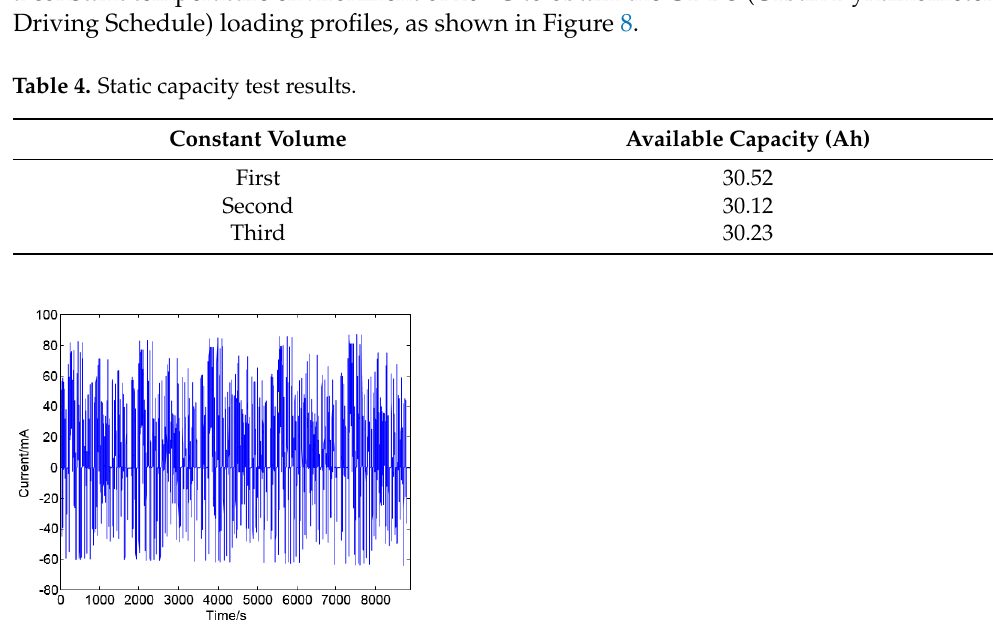
Figure 6. Recession parameter curves at different discharge rates.